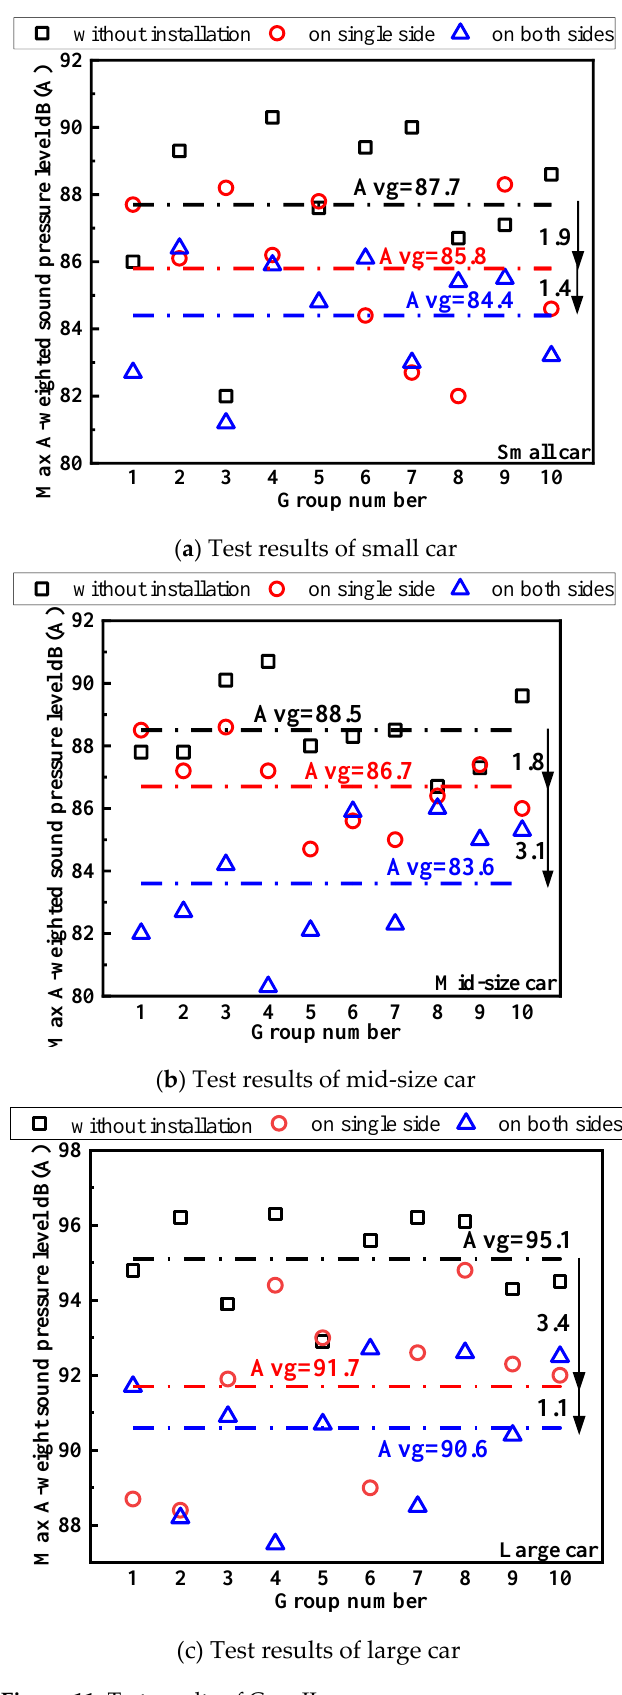
Figure 11. Test results of Case II.